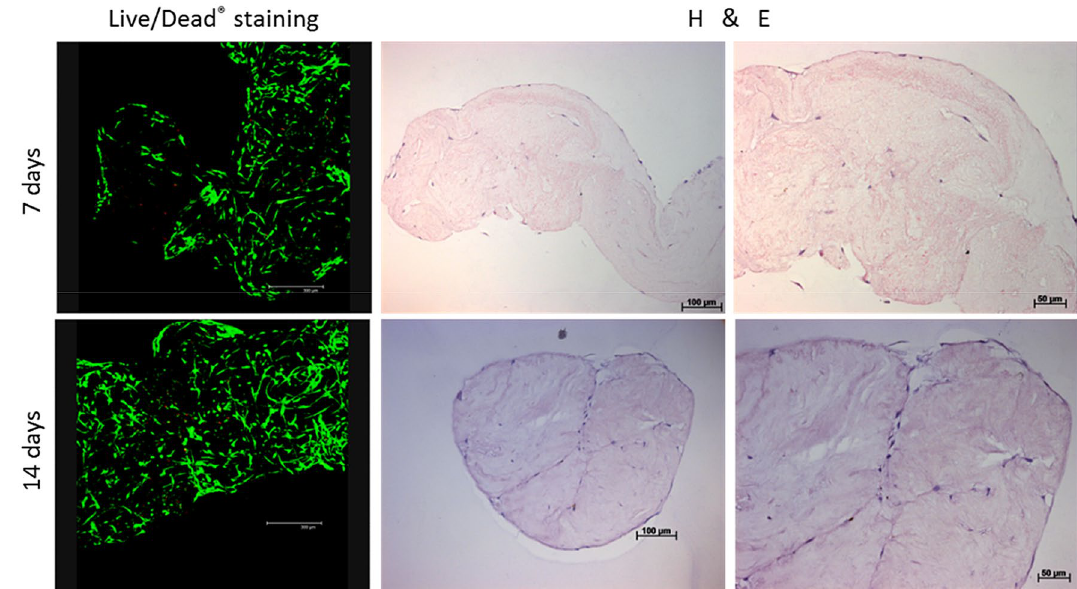
Figure 6. DPSCs viability and attachment following recellularisation of the decellularised pulp scaffold. ( a ) Confocal laser microscope images of cell viability assay following 7 and 14 day culture clearly show a well- populated scaffold with viable cells ( stained green) and scarce dead cells (stained red). Scale bars are at 300 µm. ( b ) Representative images of H&E staining revealed DPSCs attached and migrated within the decellularised scaffold. As culture time increased, the seeded scaffold contracted from longitudinal shape (day 7) to a circular shape (day 14). DPSCs dental pulp stem cells. Scale bars are at 100 and 50 µm.